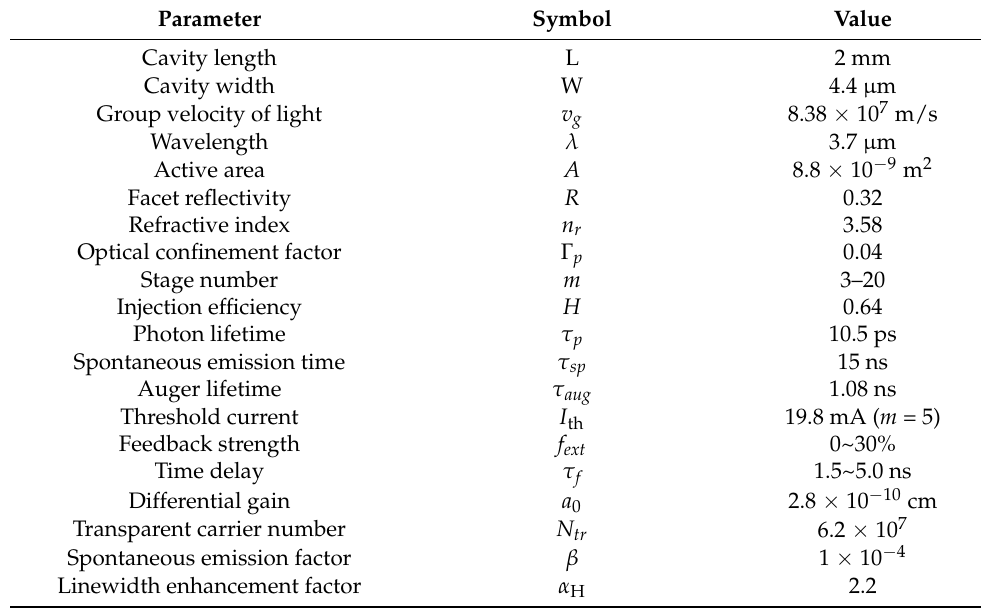
Table 1. ICL parameters used in the